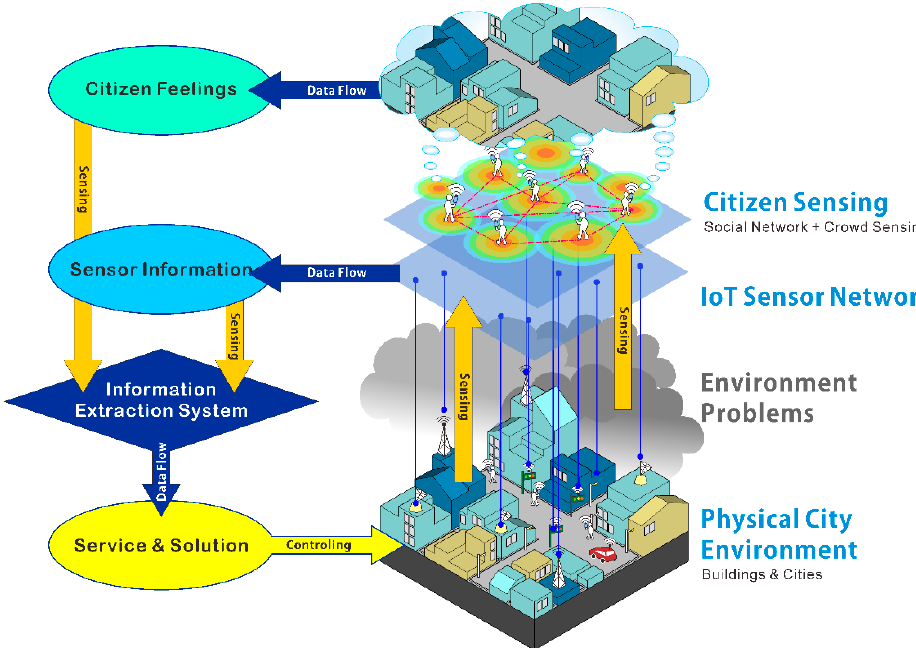
Figure 2. Importing the social-activity information layers to connect the gap between the information layer and physical environment layer in a city. Citizens are used as sensors to fill-in the gap between the physical environment and the sensor network.